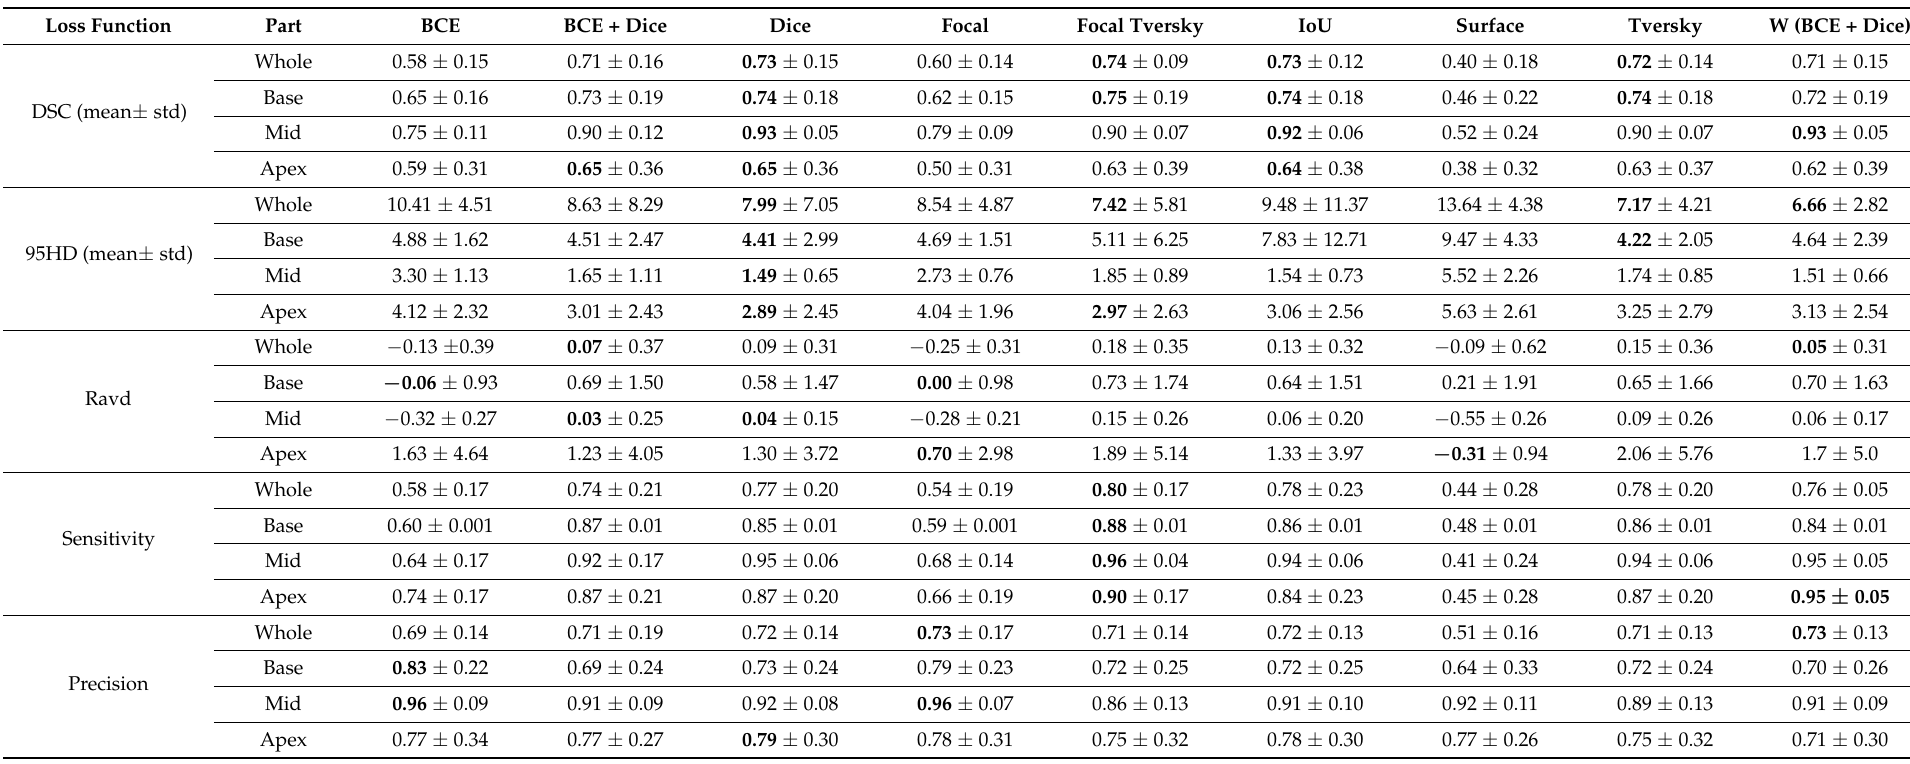
Table 2. Mean value of the five-fold cross validation for each metric used in the current study are shown for the whole gland, base, mid-gland, and apex regions. Values shown in bold represent best performing